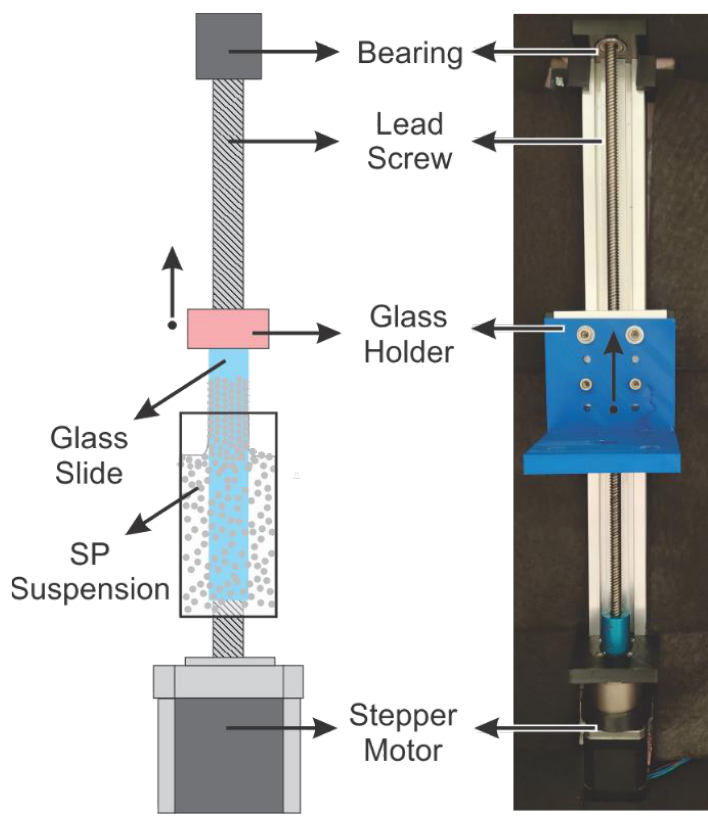
Figure 2. Custom-made experimental chamber employed for the C-PC fabrication.